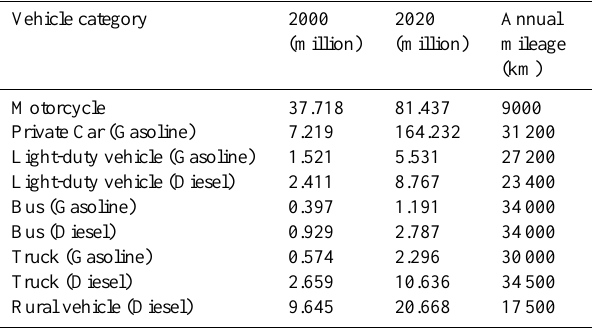
Table 2. Number of vehicles and annual